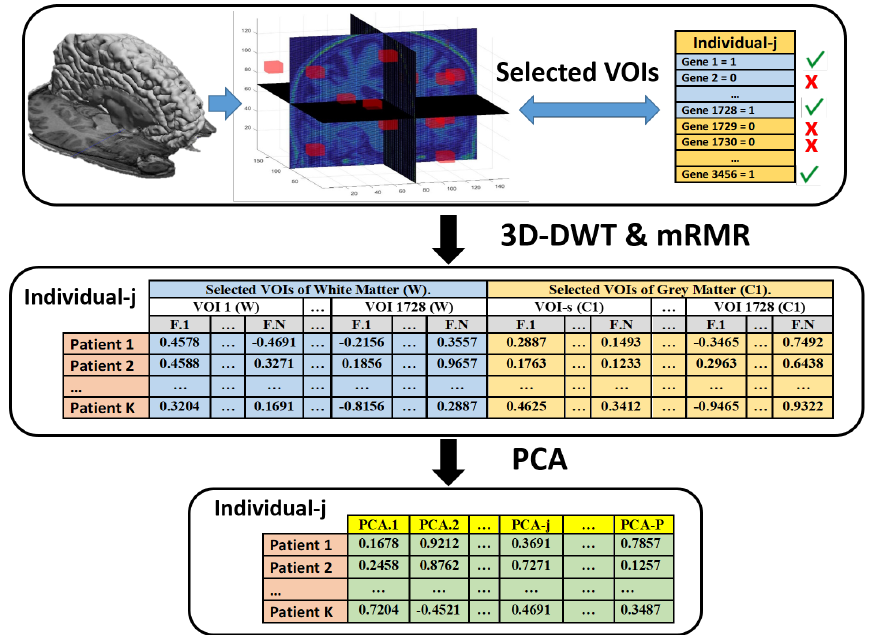
Figure 9. Block diagram of the PCA component matrix used for reducing the number of features for each patient, using a specific individual-j of the Pareto